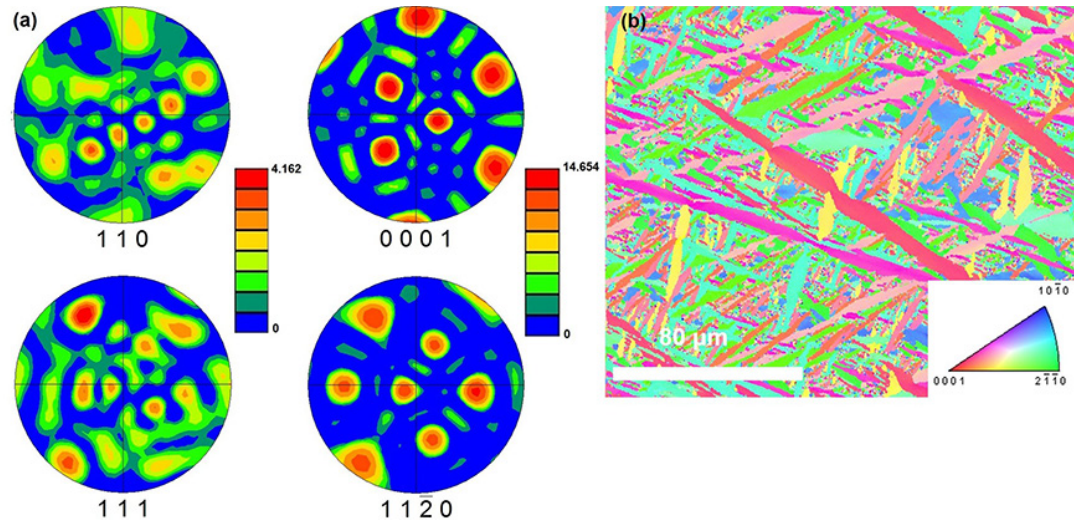
Figure 9. (a) The pole figures for β and α' phases and (b) EBSD image of 1000-30 sample.